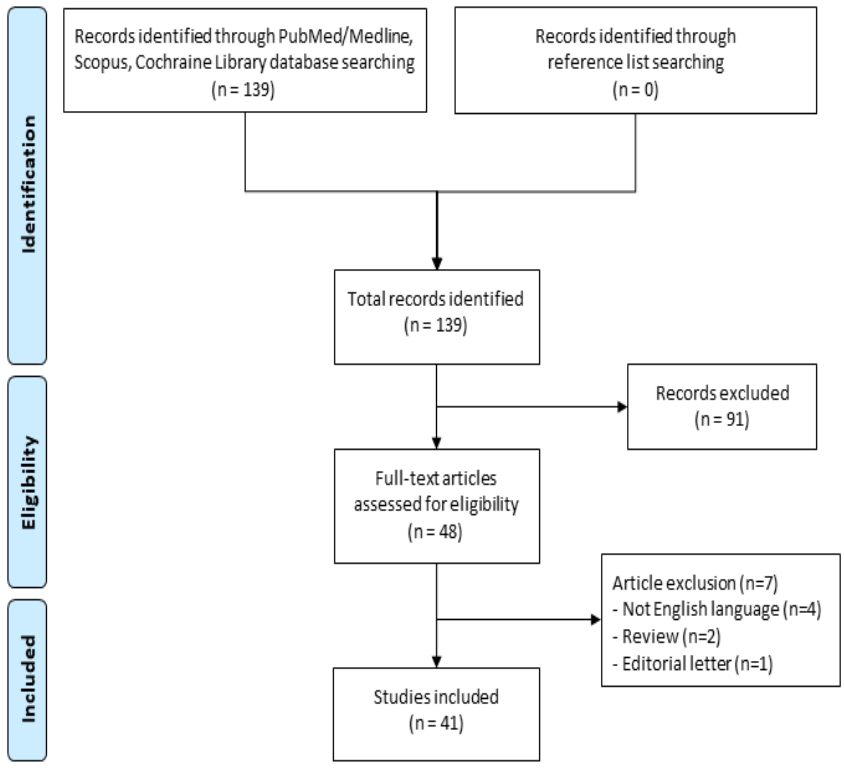
Figure 1. PRISMA flow diagram.